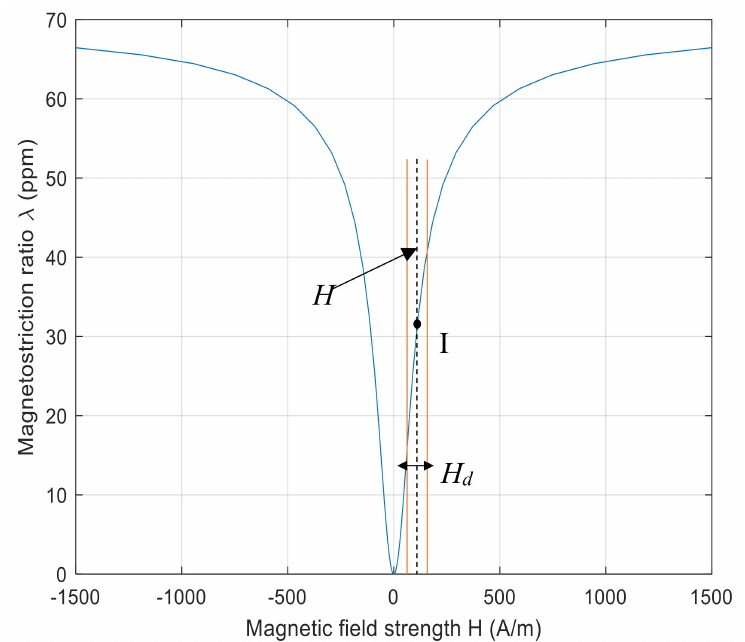
Figure 1. Magnetostriction curve ( blue line ) for an iron-cobalt alloy with the operating range of the applied dynamic field indicated by the vertical brown